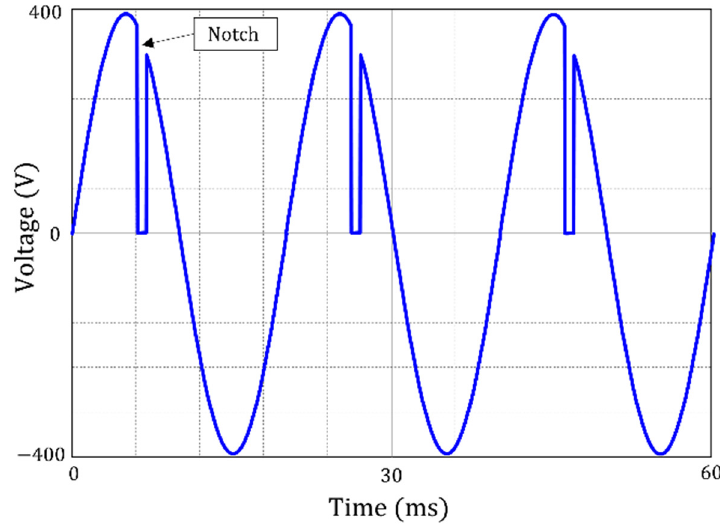
Figure 7. Example of sinusoidal voltage signal with notch perturbation.